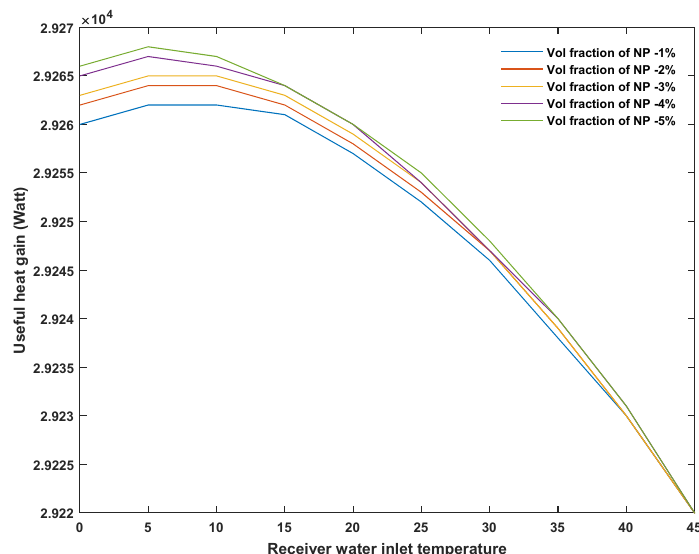
Fig. 9. Effect of Volume fraction on receiver useful heat